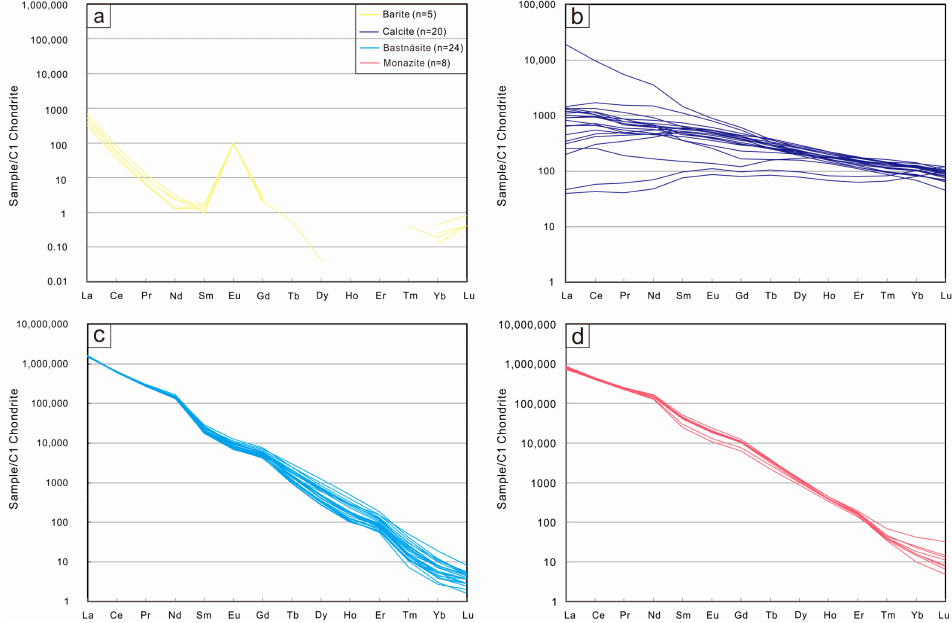
Figure 7. Chondrite-normalized REE patterns for ( a ) barite, ( b ) calcite, ( c ) bastnäsite, and ( d ) monazite in disseminated ores. Normalizing values are after [57].